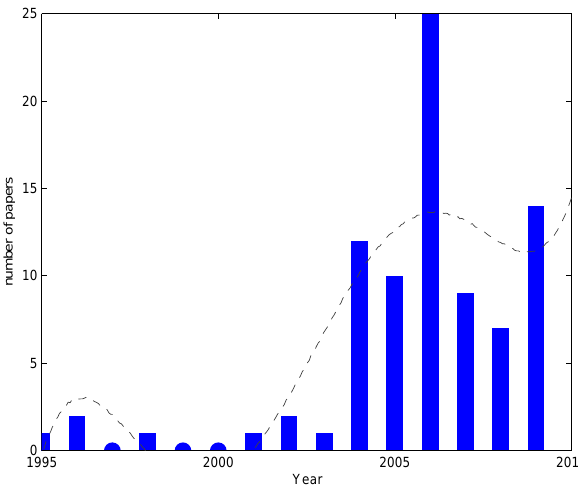
Figure 2. Publication activity in underactuated